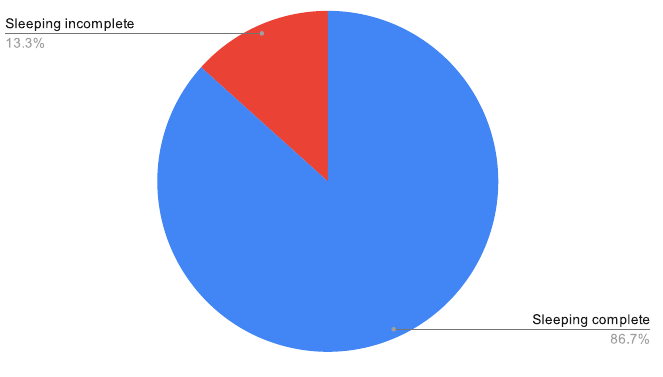
Figure 13. Sleep Cycles After Experiment.